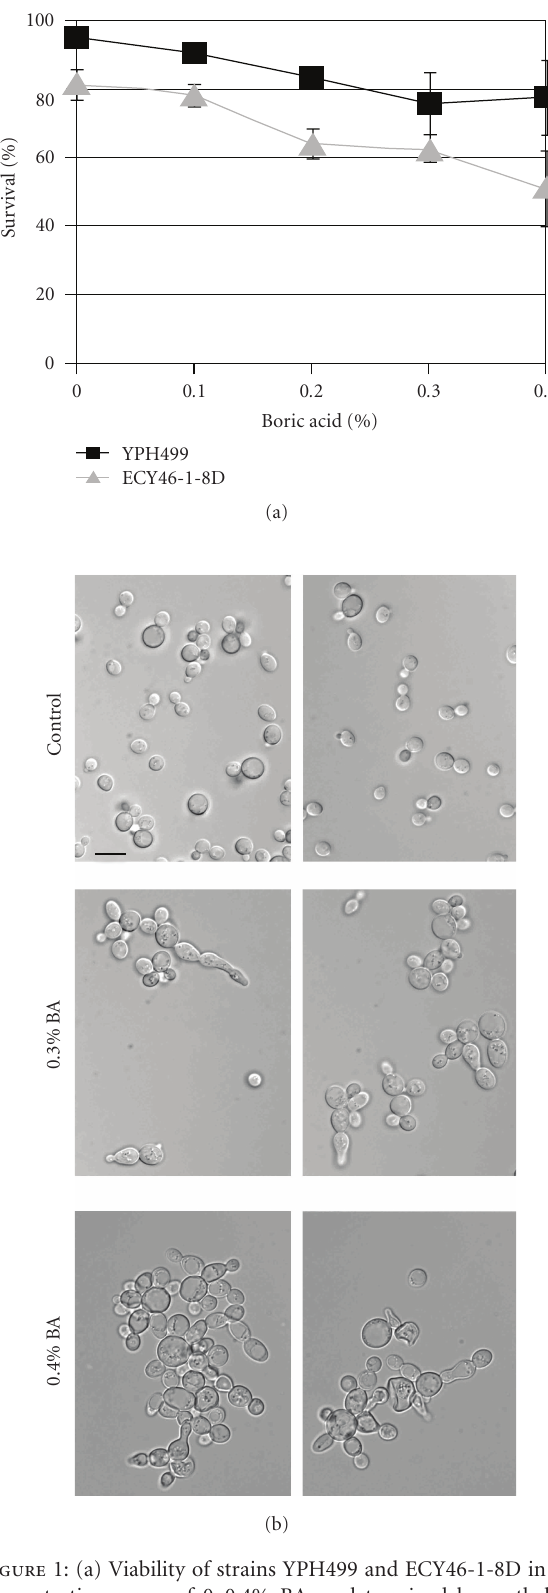
Figure 1: (a) Viability of strains YPH499 and ECY46-1-8D in the concentration range of 0–0.4% BA as determined by methylene blue staining. (b) Changes in morphology of YPH499 during exposure to BA. Cultures grown with BA show clumps and chains of incompletely separated cells. The scale bar represents 5 μ